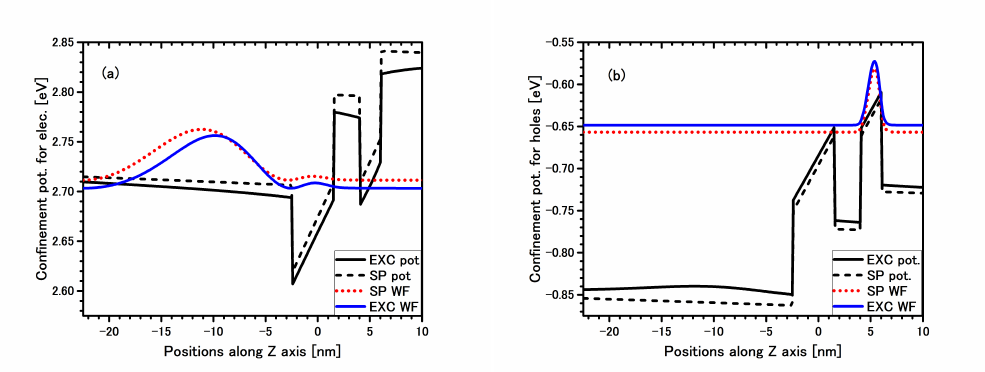
Figure 7. Band edge profile potentials (black lines) with single particle (SP) wave-function (WF) (dotted red line) and excitonic multiplier of the WF (solid blue line) for electron ( a ) and hole ( b ) for indirect EL2 exciton in QW 4 nm are presented in the structure #3. Solid black lines are confined potential with additional Coulomb term (Equation